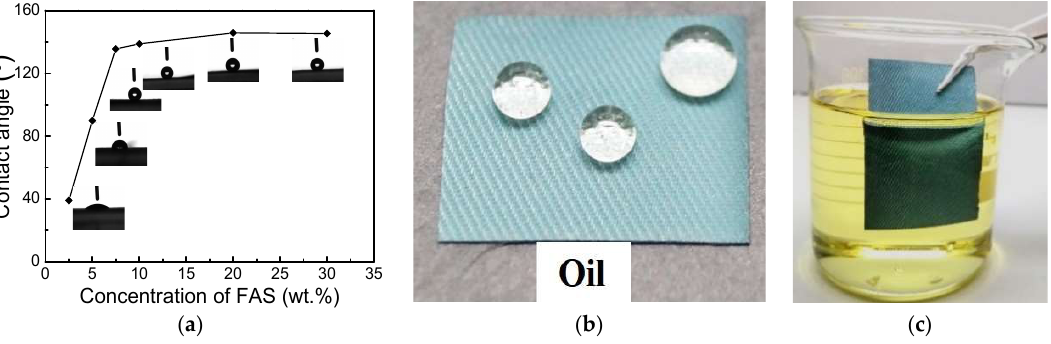
Figure 10. ( a ) The effect of FAS concentration (wt %) on oil CA of the structurally colored fabrics; ( b ) Three salad oil droplets stand on the structurally colored fabric with FAS concentration of 20 wt %; ( c ) Photograph of FAS-SiO 2 structurally colored fabrics immersed into salad oil.